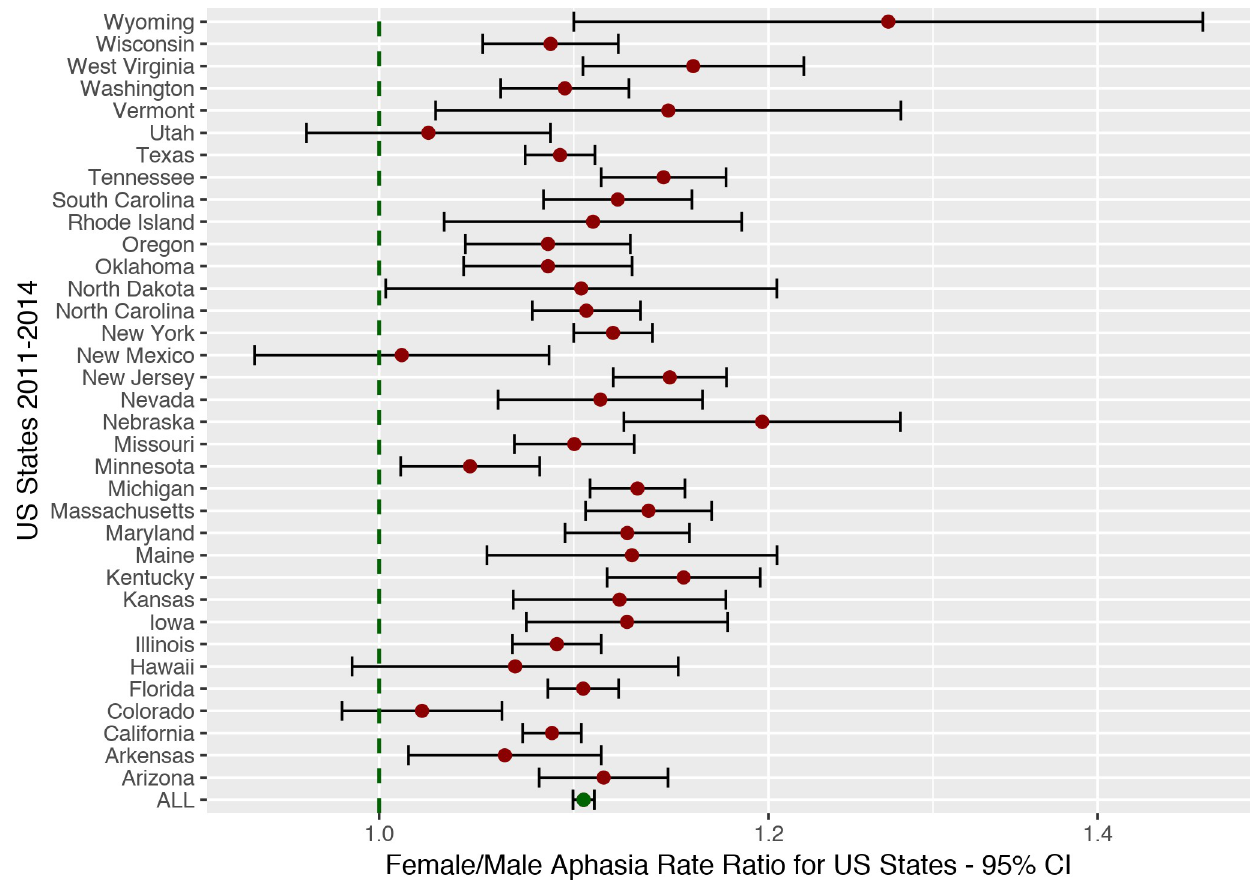
Fig 4. US data forest plot. Aphasia rate ratios (uncorrected for age) for each US state in the HCUP database from 2011–2014. This analysis replicates the findings from the meta-analysis and provides unequivocal evidence for a higher aphasia rate among women compared to men given stroke (see Fig 1, but note the scale difference between plots). However, as Fig 5 shows, this effect can be explained completely by the sex difference in age at stroke.